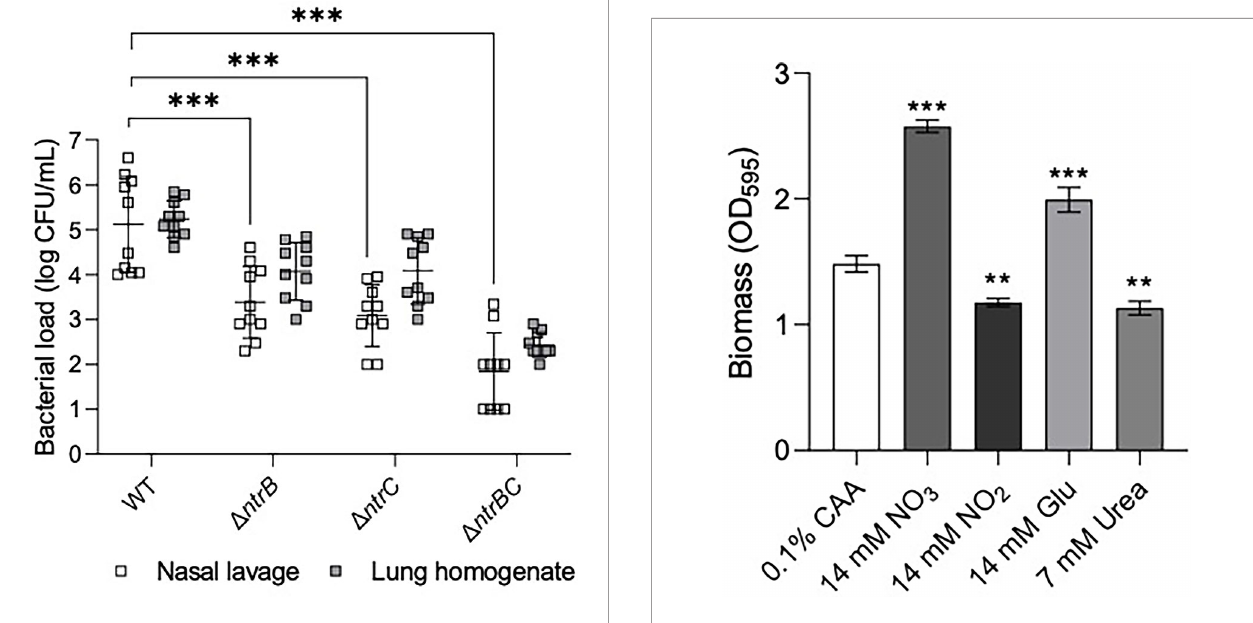
FIGURE 3 | Mutation of the nitrogen regulatory two-component system, NtrBC, reduced bacterial load of P. aeruginosa in a murine model of sinusitis. Stationary-phase bacteria were inoculated dropwise in the left naris of C57Bl/ 6 mice (10 6 CFU). 72 h later mice were euthanized, and lung tissue or nasal lavage fl uid was collected for bacterial enumeration following serial dilution. Signi fi cantly less bacteria were recovered from the lungs and nasal cavities of mice infected with P. aeruginosa D ntrB , D ntrC or D ntrBC mutants. Data are presented as geometric mean ± standard deviation for three independent experiments containing 3-4 biological replicates each ( n = 10). *** P < 0.001 according to Two-Way ANOVA followed by Dunnett ’ s post-hoc analysis.